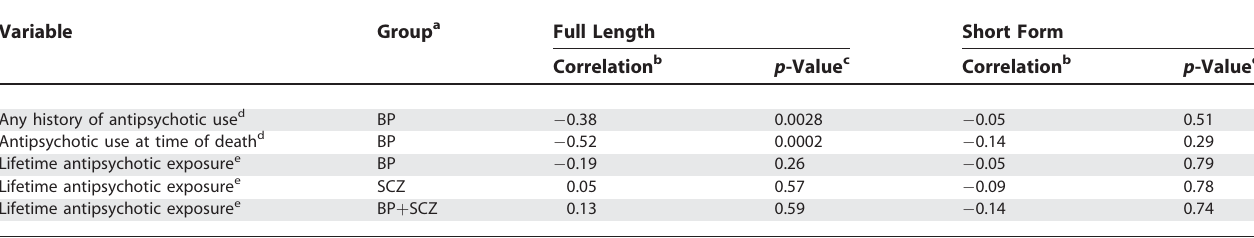
Table 2. Effect of Antipsychotic Treatment on CAPON Isoform Expression Variable Group